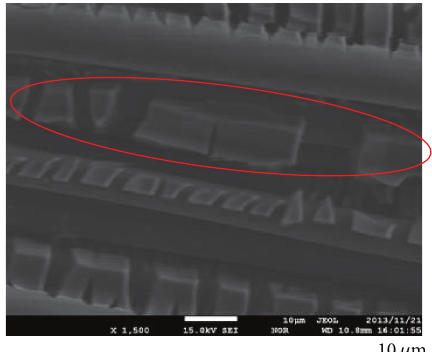
Figure 4: SEM image of TiO 2 film coated on netlike glass disc.